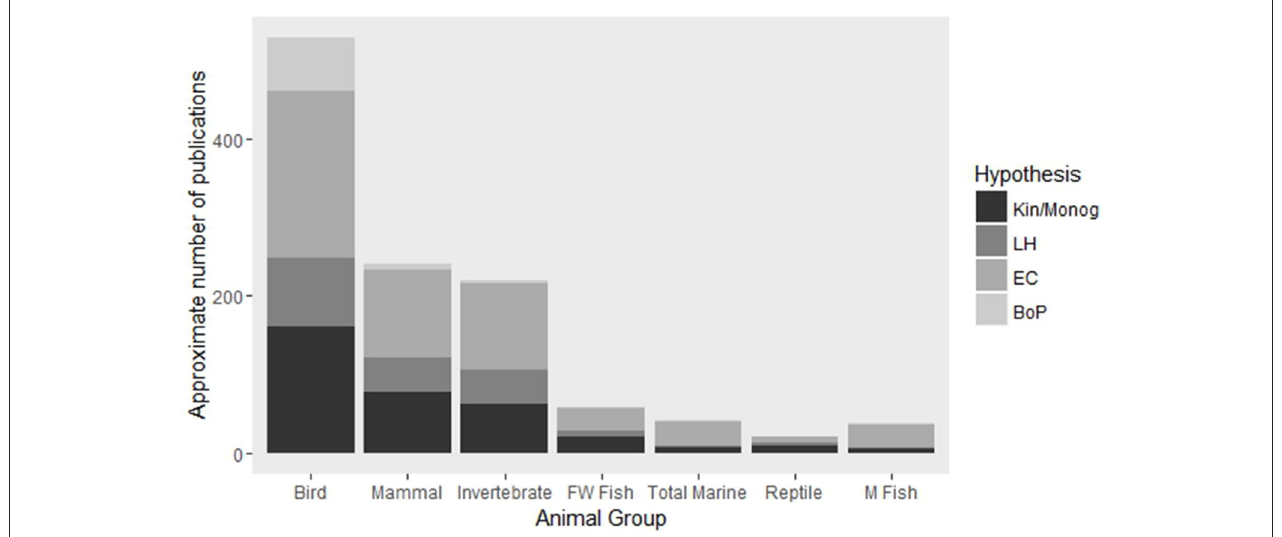
FIGURE 1 | Approximate number of articles published on major animal groups focusing on four key hypotheses of cooperative breeding. Abbreviations are: Kin, Kinship; Monog, Monogamy; LH, Life-history; EC, Ecological Constraints; BoP, Benefits of Philopatry; FW, Freshwater; M, Marine. Search parameters are available in Supplementary Table S1. Numbers presented here are intended as approximations only as search parameters were not completely mutually exclusive or exhaustive.